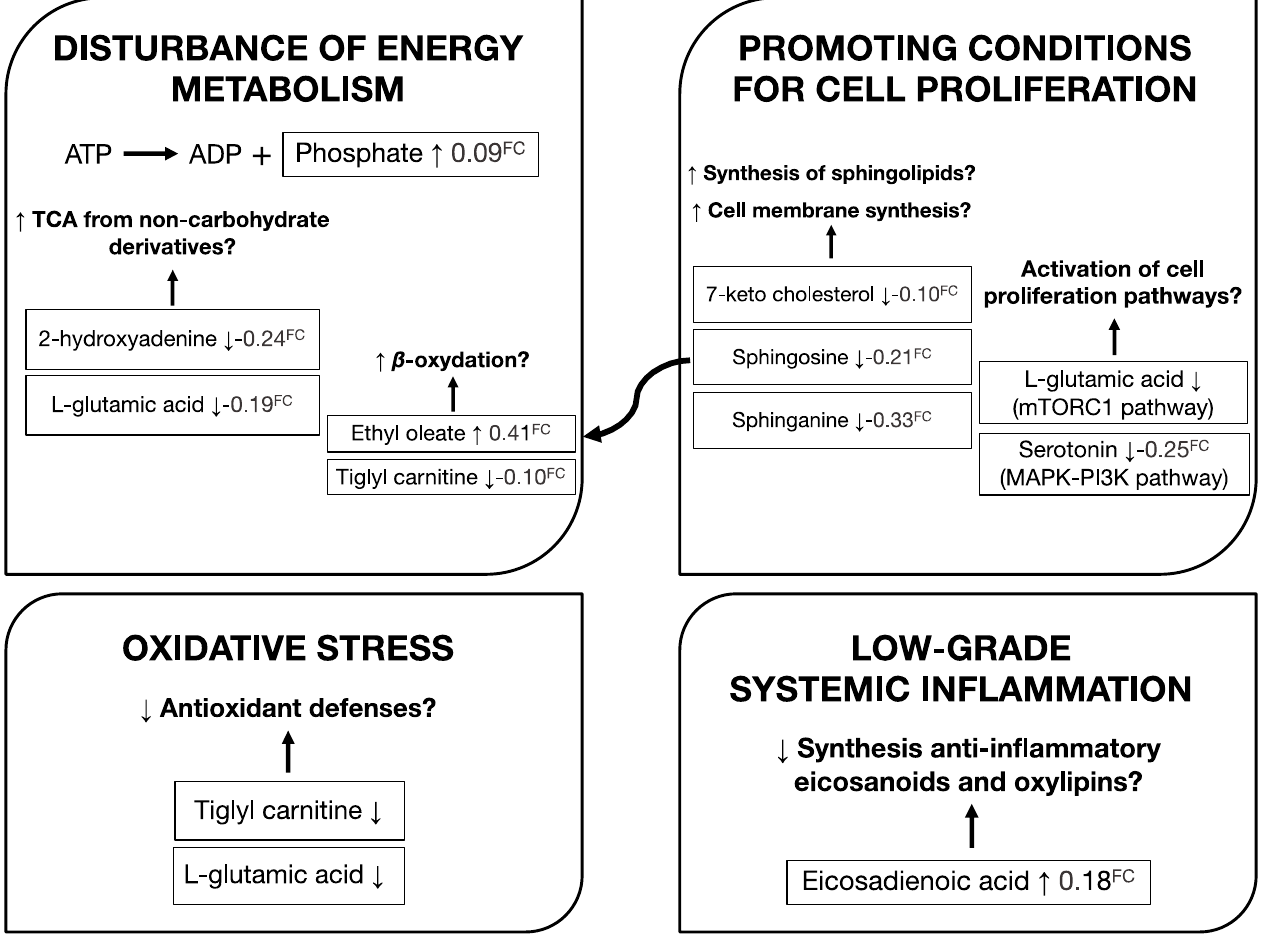
Figure 6. A model for metabolic changes during development of prostate cancer. Among these 10 important metabolites ( p < 0.001) in the discrimination of PCa cases from controls, the majority are related to amino acids and sphingolipid metabolism and participated in energy metabolism, cell proliferation, oxidative stress, and inflammation. Our results suggest possible changes or perturbations in these physiological processes in males who subsequently developed PCa during the follow-up. FC: fold change.